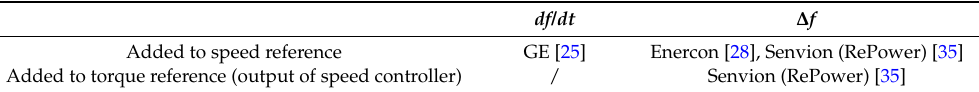
Table 1. The existing industrial inertia control of main WTs manufacturers.